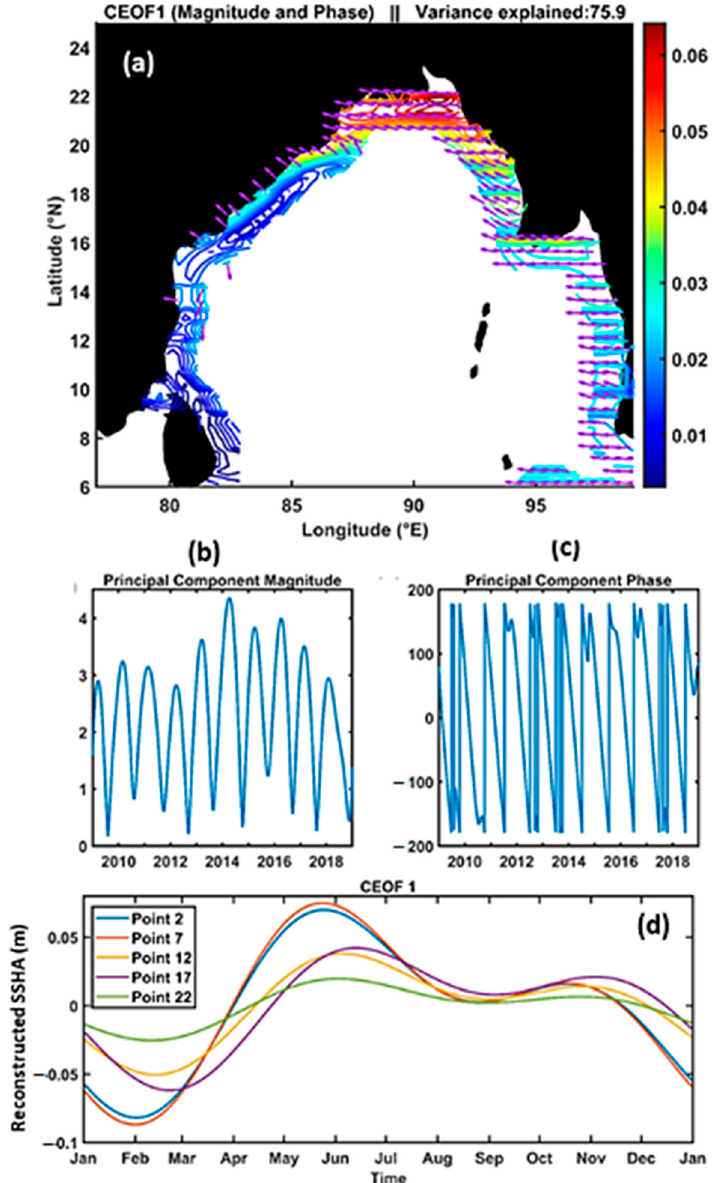
Figure 9. First mode of SSHA in the study region: ( a ) Magnitude (colored contours) and phase (purple arrows) of EOF; ( b ) Magnitude of PC, ( c ) phase of PC, and ( d ) climatology of the reconstructed coastal SSHA around points 2, 7, 12, 17, and 22.